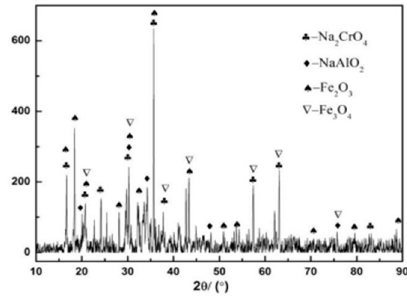
Figure 9. XRD pattern of microwave roasted product.